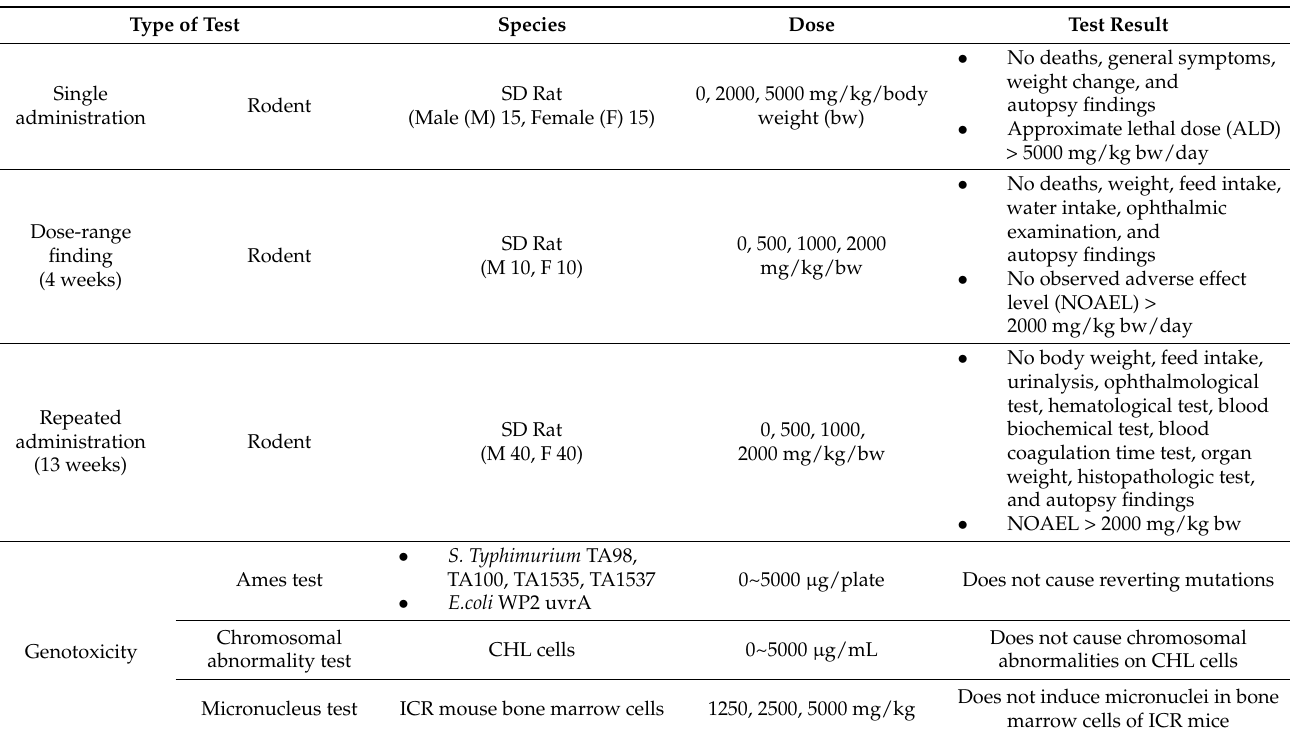
Table 1. Toxicity test results of